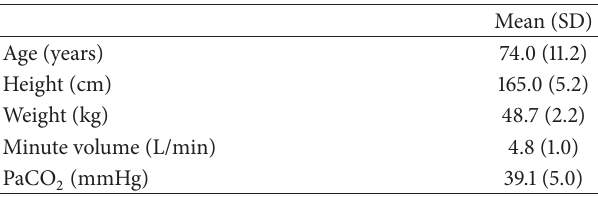
Table 3: Minute volume and PaCO 2 levels of 29 male patients (aged 48–90) subjected to nonlaparoscopic